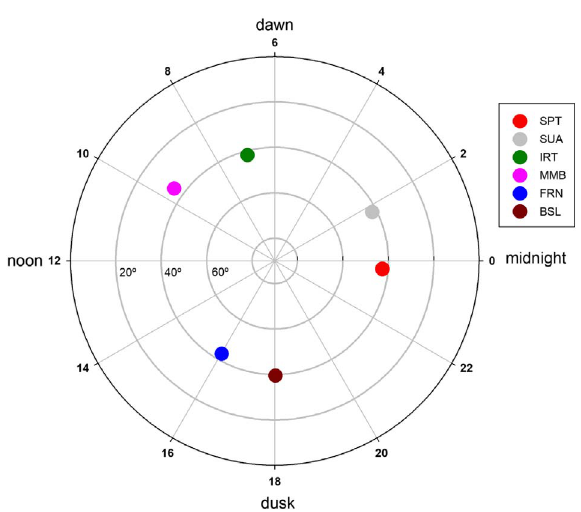
Fig. 3. Distribution of the six magnetic observatories selected. The MLT location shown corresponds to 00:00